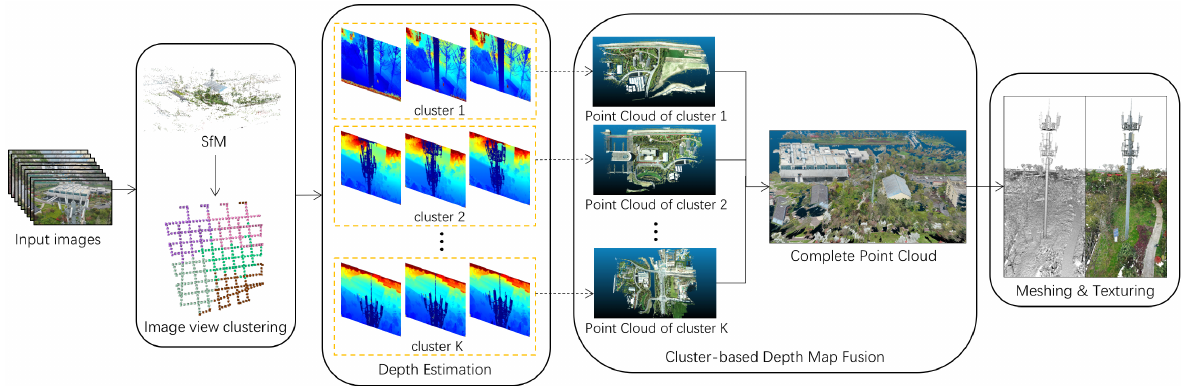
Figure 1. System framework of DP-MVS, which consists of six modules including SfM, image view clustering, detail preserv- ing depth map estimation, cluster-based depth map fusion, detail-aware surface meshing, and multi-view texture